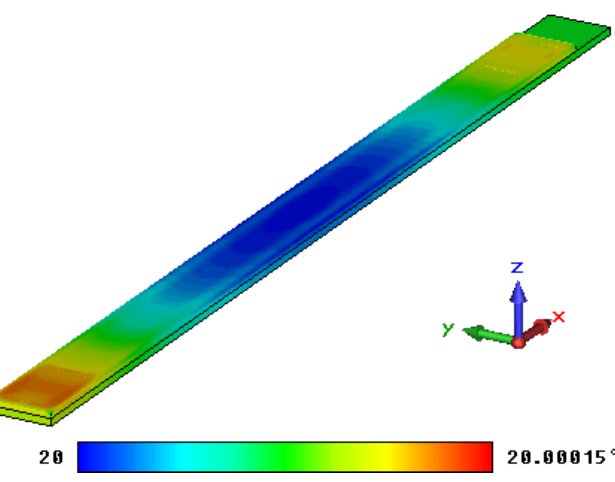
Figure 18. Temperature field based on eddy current.